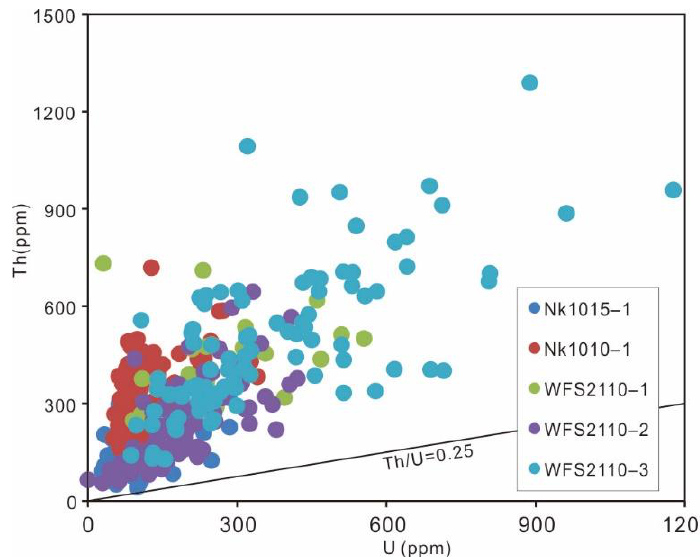
Figure 5. Th–U ratios of the tested zircons of the